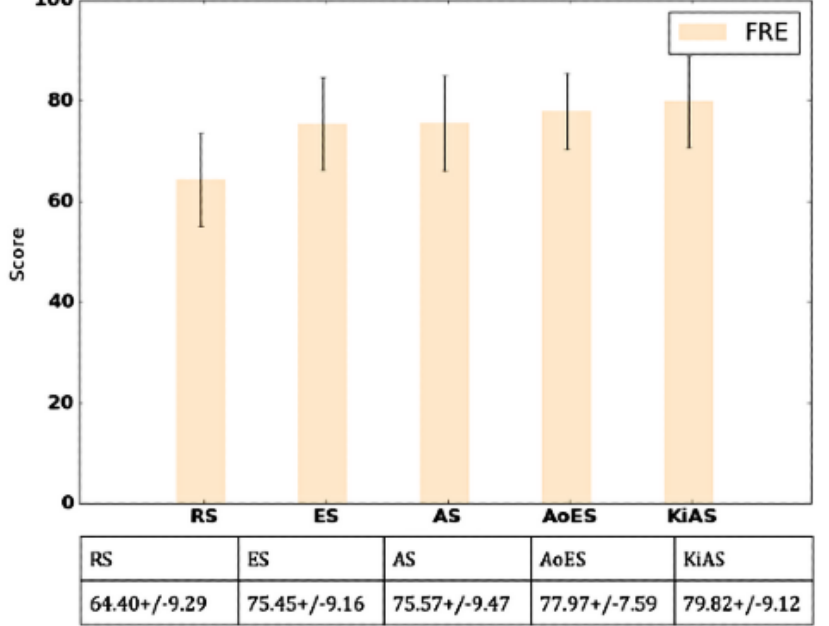
Figure 7. Evaluating readability of the generated summaries from RS. FRE method assesses comprehensibility and engagement of the summaries. AoES: abstraction over extractive summarization; AS: abstractive summarization; ES: extractive summarization; FRE: Flesch Reading Ease; KiAS: knowledge-infused abstractive summarization; RS: reference